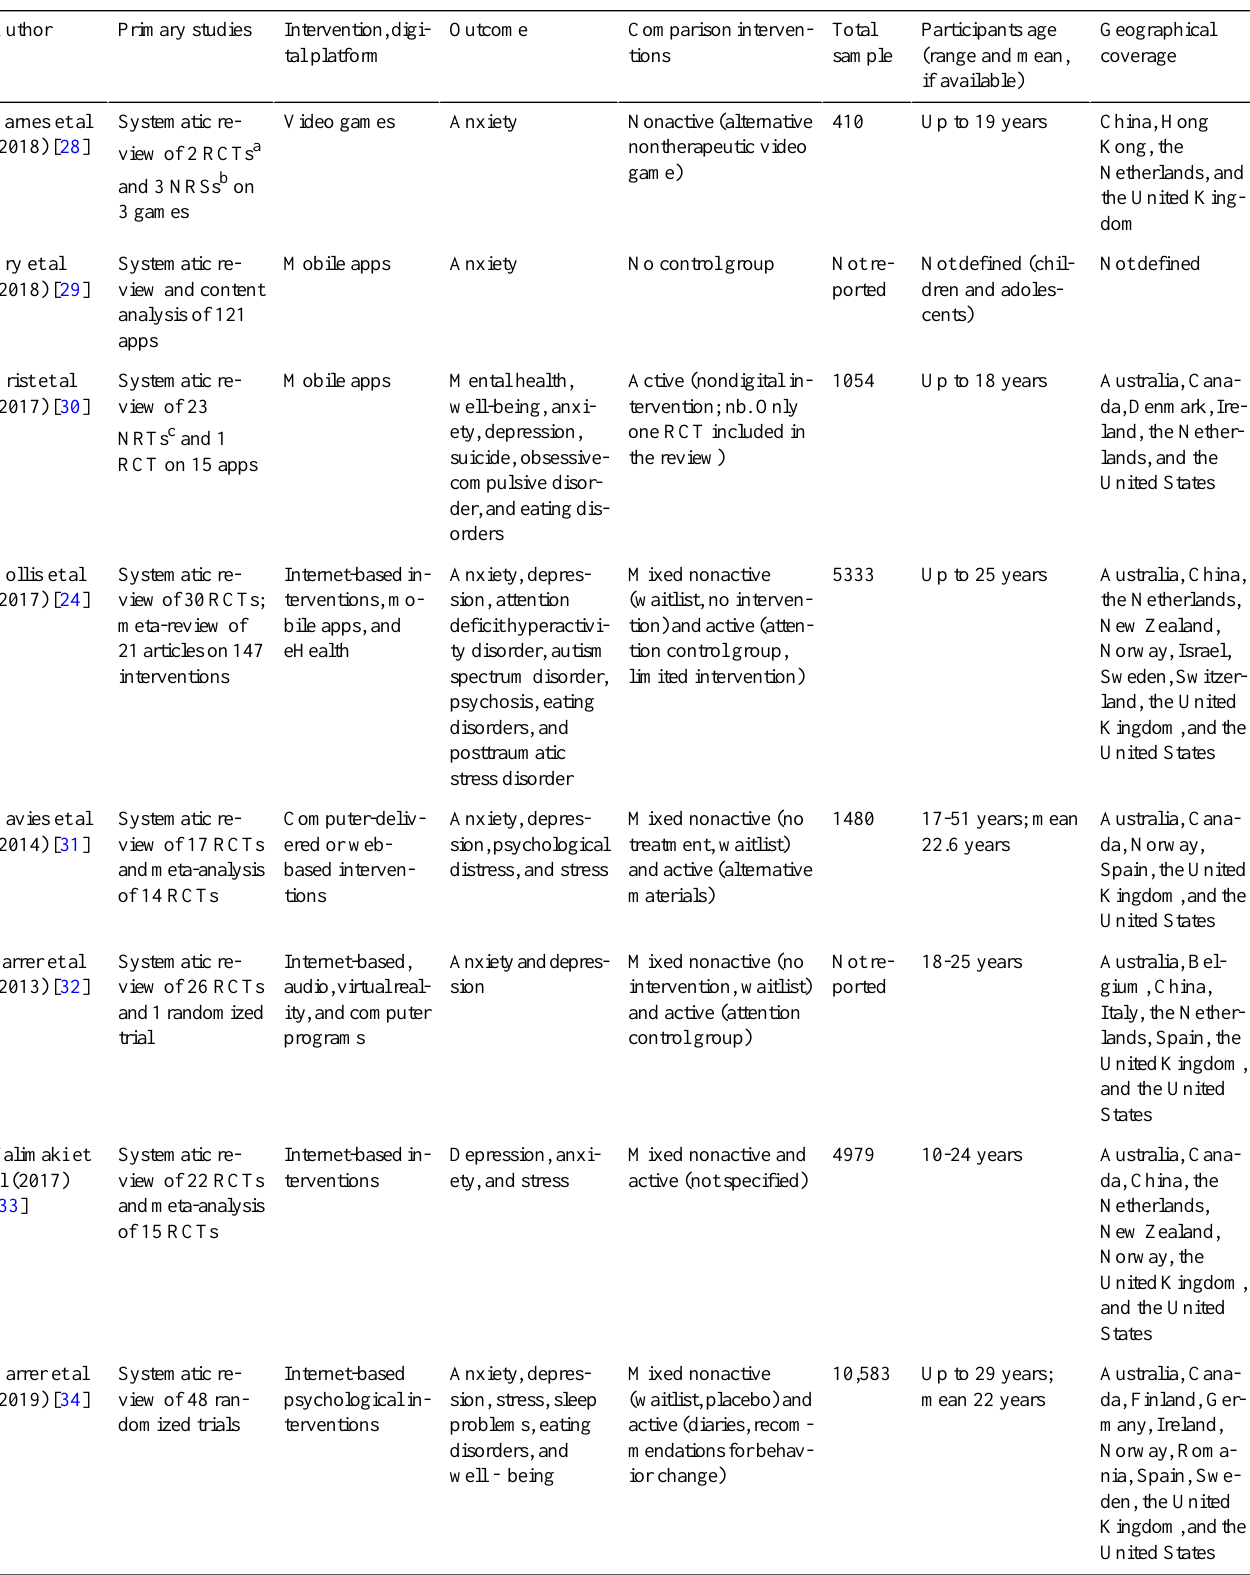
Table 1. Study characteristics.